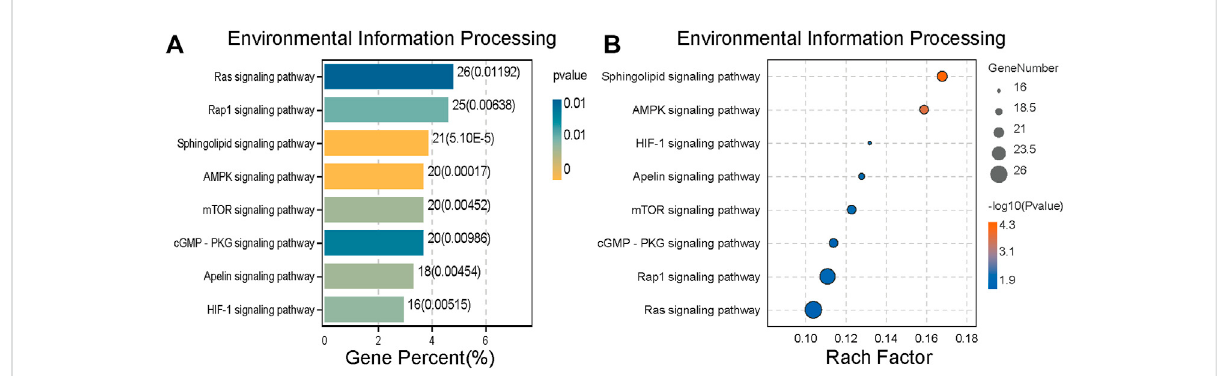
FIGURE 5 Environmental information processing of differential protein expression. (A) Histogram of Environmental Information Processing ranked by Gene Percent. (B) The bubble chart of Environmental Information Processing is sorted by the Rach factor. The bar chart and bubble chart show the top eight channels of Environmental Information Processing. The more yellow the color, the lower the p value and the higher the credibility.